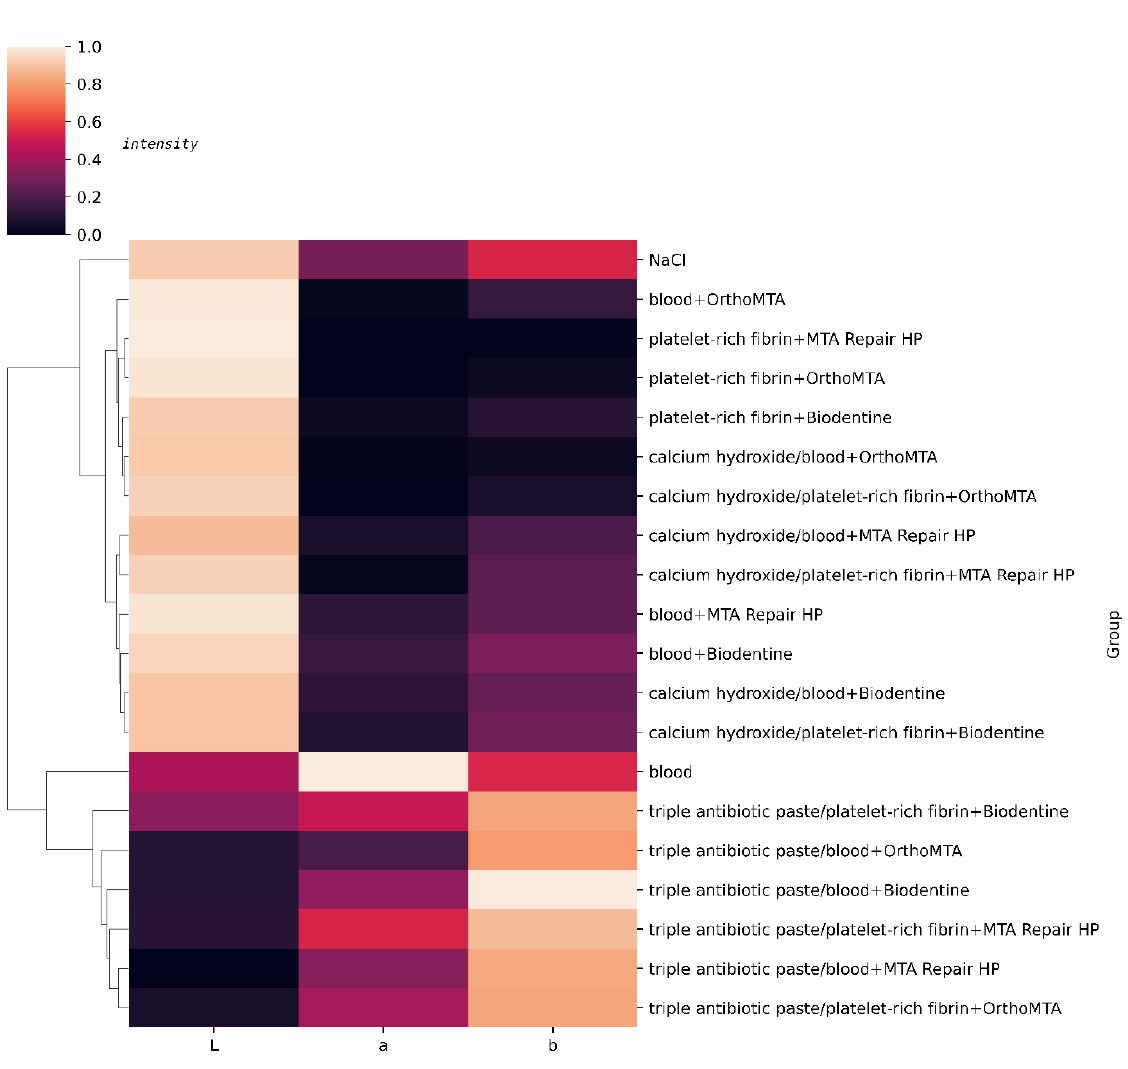
Figure 11. Hierarchical clustering dendrogram and heatmap for L, a, and b values after first bleach- ing procedure.